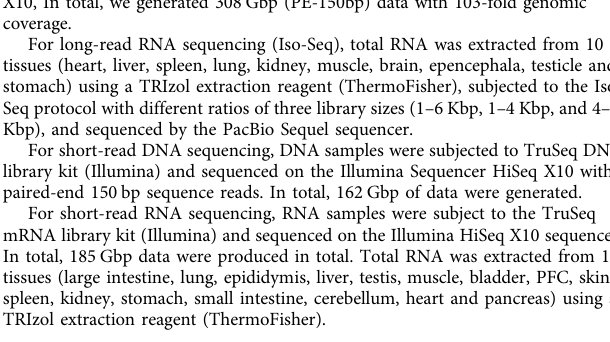
in the rheMacS assembly. The base-error rate was calculated as the number of homozygous sites divided by the total size of the rheMacS assembly (Supplementary Table 8). Mappability: 50 ×depth WGS data were generated by Illumina sequencer HiSeq X10 (PE-150 bp) for fi ve rhesus monkeys, which was used to evaluate the mappability and availability for variant calling. We used FastQC and GATK to perform quality control (QC) for the Illumina WGS reads, and then we mapped these short reads to rheMacS and rheMac8 assemblies, respectively, using the BWA-MEM module. SAMtools and GATK standard pipeline were used to call variants. Delly (v0.7.7) 70 was used to call SVs. All underlying algorithm, tool versions, and command lines for variant calling and fi ltering are listed in Supplementary Table 21. Gene annotation . For gene annotation, 119.01 million RNA-seq reads and 1,275,860 Iso-Seq reads were generated with a mean length of 2791 bp (Supple- mentary Fig. 27). Gene models were constructed with MAKER (v2.31.8) 71 , which incorporated